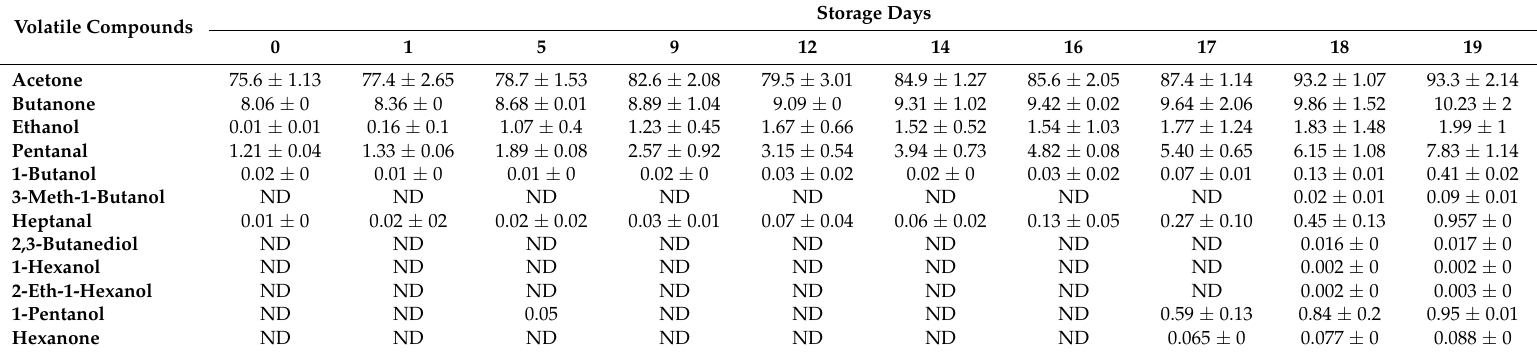
Table 1. Means values and standard deviation of volatile compounds ( µ g/L) of pasteurized milk stored at 4 ◦ C.